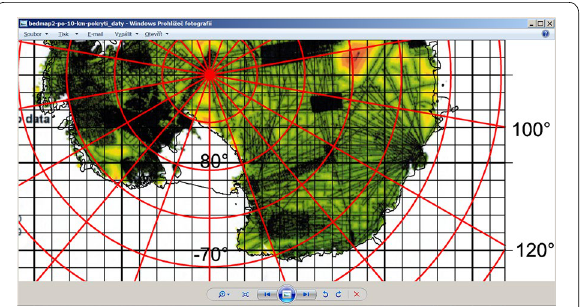
Fig. 5 Data distribution (mostly ground tracks of ice-penetrating radars RES) in Bedmap 2 in the Wilkes Land area (up to the subglacial Lake Vostok in west and Marie Byrd Land on east). Compare with Figs. 3 and 4. Reproduced from Fig. 3 in (Fretwell et al. 2013)